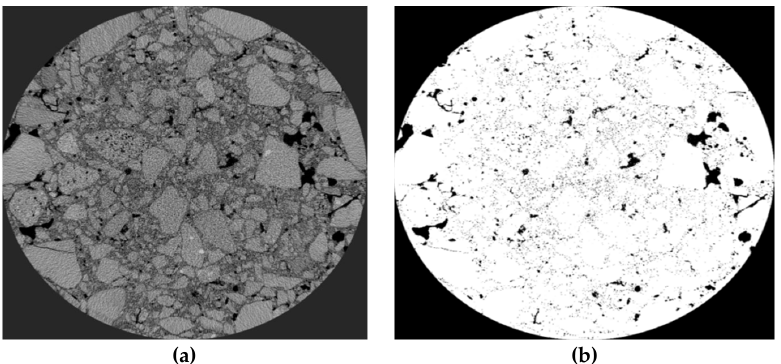
Figure 14. Section image processed by software. ( a ) Gray-scale image. ( b ) Space image after pro- cessing.